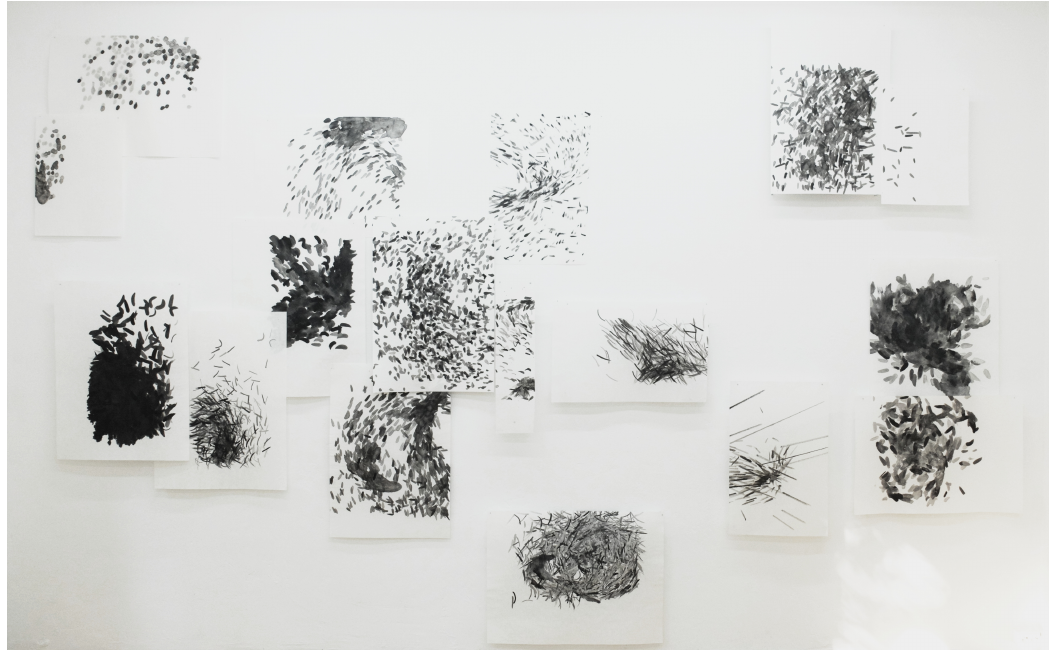
Figure A5. “Simulation of a World Overview”, Exhibition view: “Traversing the Threshold” Room Installation of Robotics-Assisted Calligraphic Works and Videos in Collaboration with the e-David Project (University of Konstanz) and Video Artist Marcus Nebe. Exgirlfriend gallery, Berlin 2018. Photo c (cid:13) Gabrielle Fougerousse and Exgirlfriend